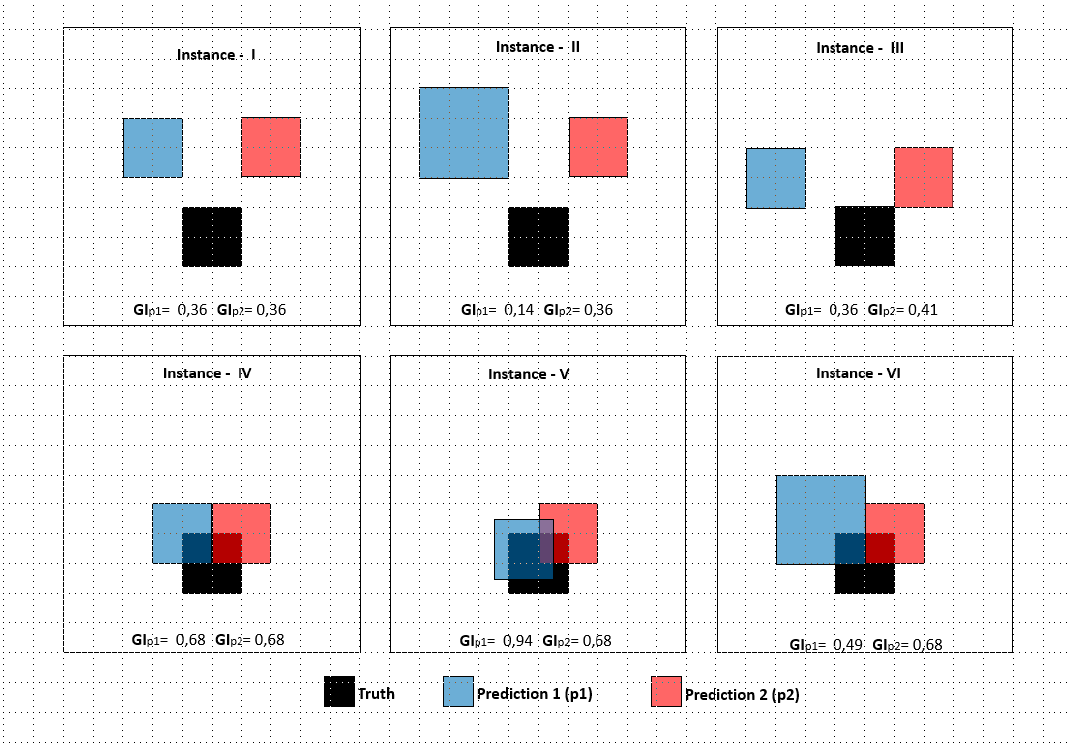
Figure 7. Giz Index (GI) similarity test over six instances.